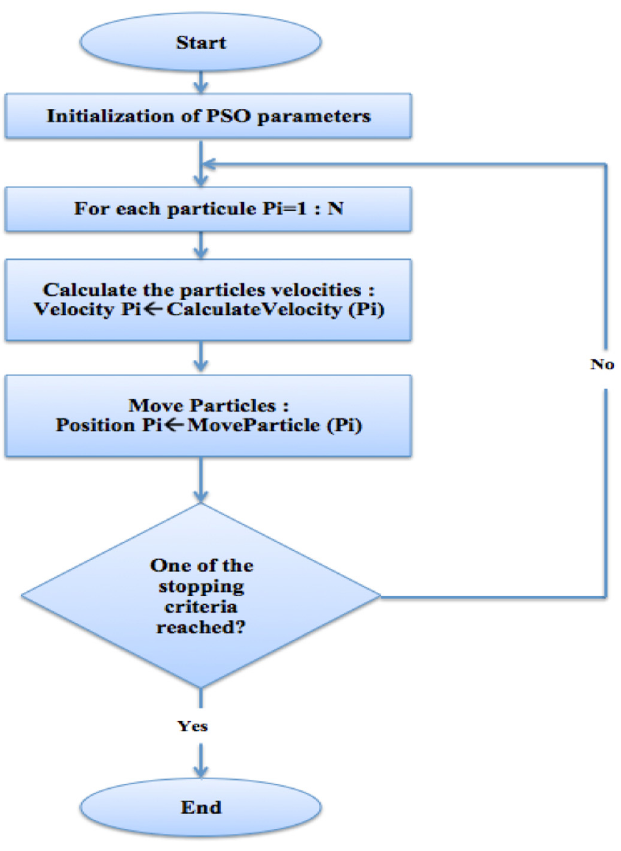
Fig. 2. The basic PSO algorithm fl